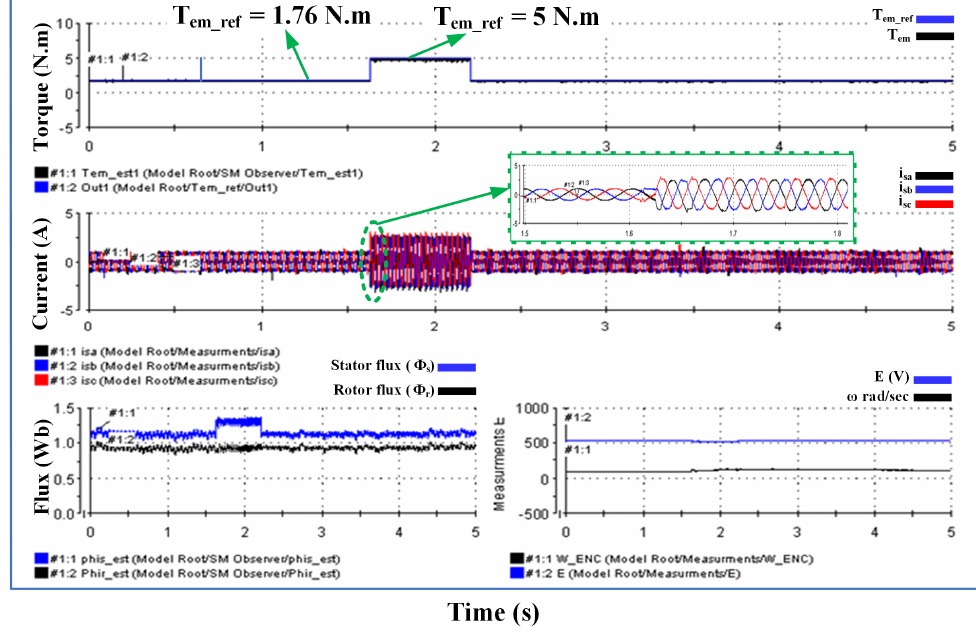
Figure 34. The performance of DTRFC with successive steps of the reference